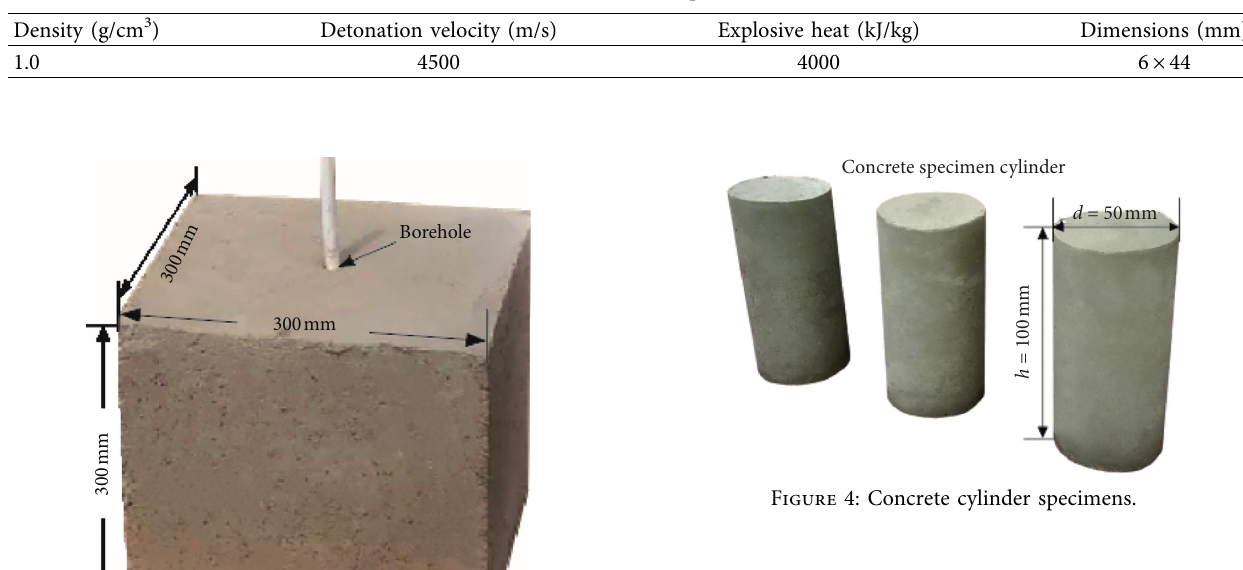
Table 2: Parameters for the DDNP special electric detonator.